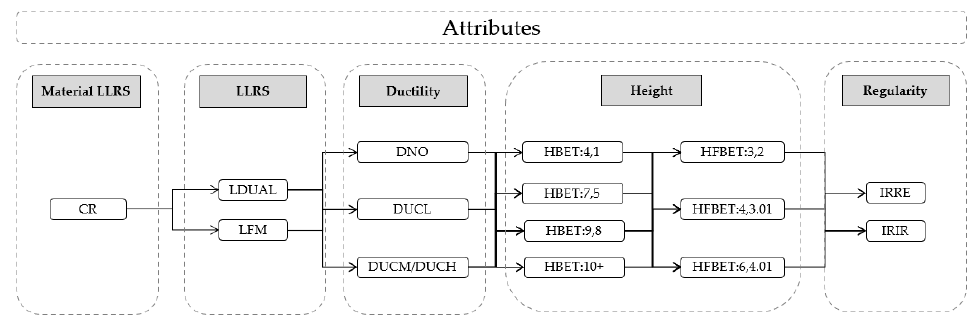
Figure 6. Schematic diagram of the proposed building classes defined for Lisbon RC building stock.